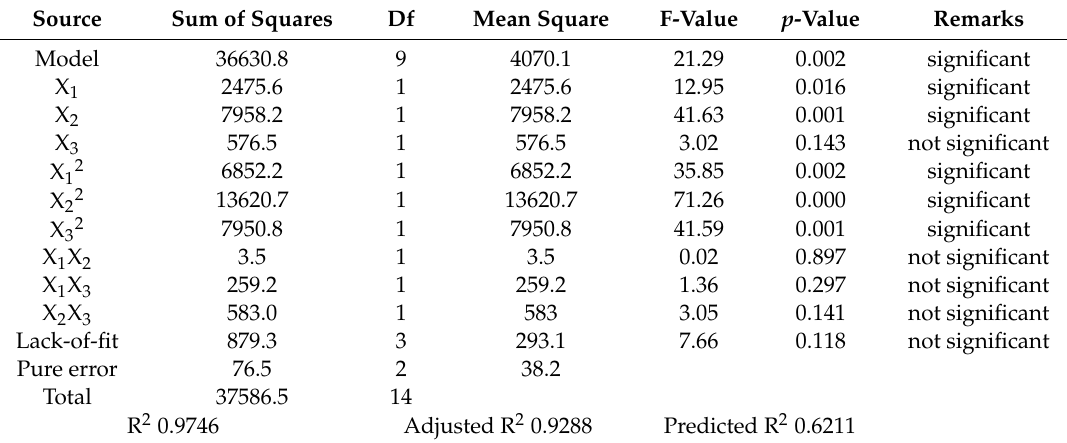
Table 5. ANOVA for determining the fitting of the quadratic